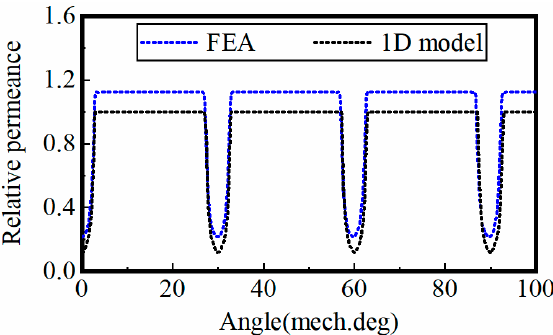
Figure 4. The 1D model relative permeance results comparison with FEA.